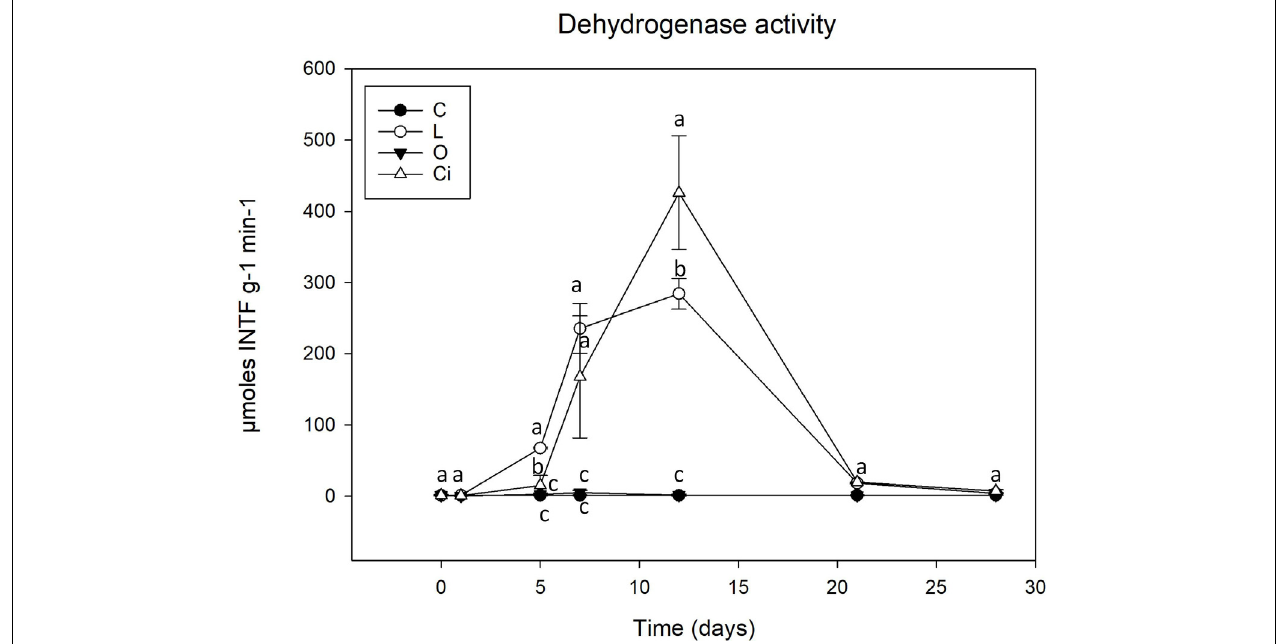
FIGURE 4 | Acid phosphomonoesterase activity in soil samples. C, control sample; L, lactic acid treated sample; O, oxalic acid treated sample; Ci, citric acid treated sample. Different letters indicate significant difference among treatments ( p < 0.05).